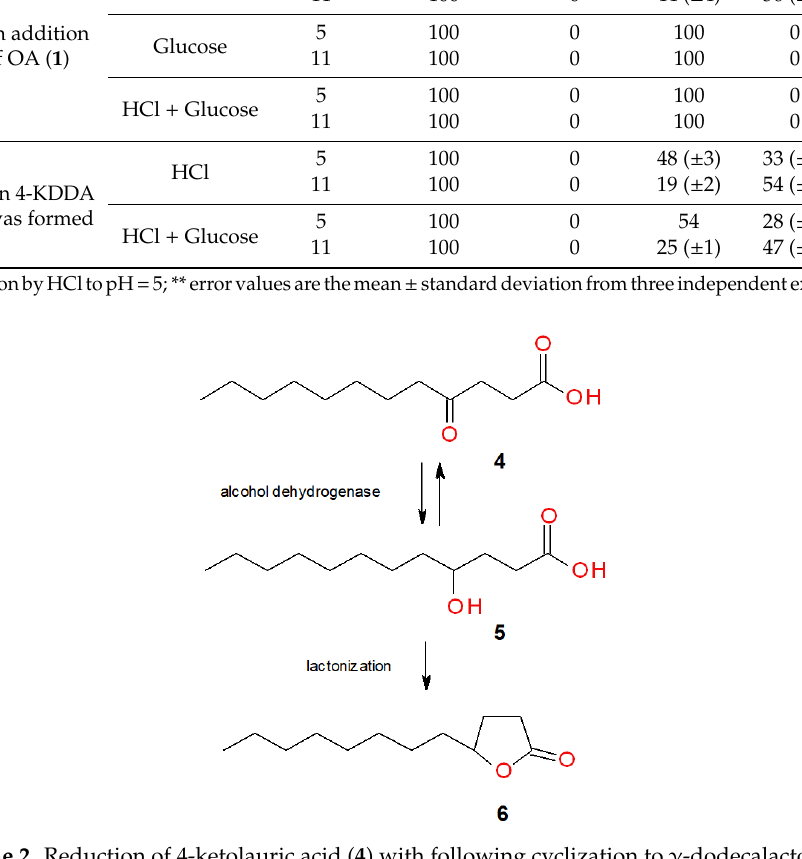
Table 3. Effect of pH and glucose supplementation (1%) on transformation of oleic acid ( 1 )